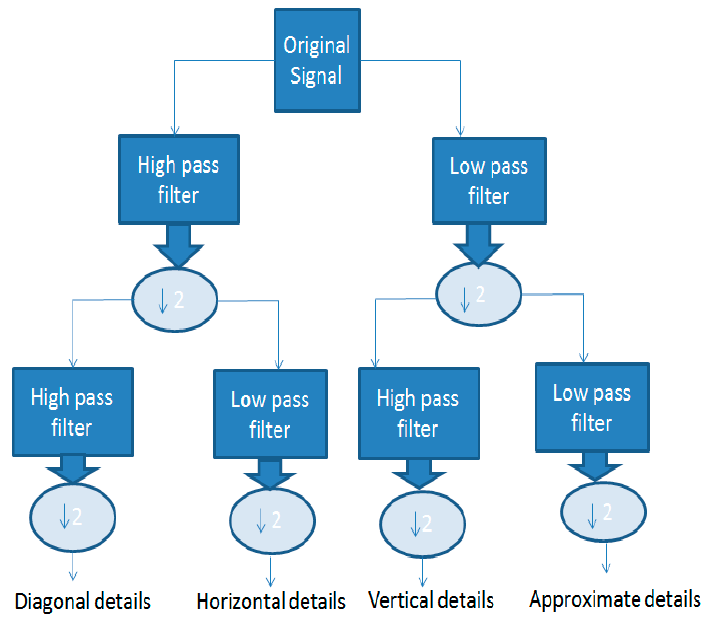
Figure 6. Decomposed details after applying wavelet functions.